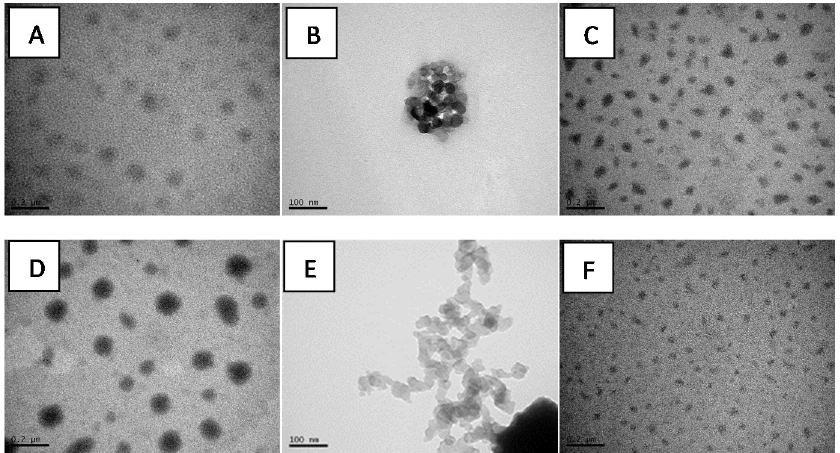
Figure 1. TEM micrographs of 30BSA/70ALG ( A ), 30BSA/70ALG–Fol ( B ), PTX-loaded 30BSA/70ALG–Fol ( C ), 50BSA/50ALG ( D ), 50BSA/50ALG–Fol ( E ) and PTX-loaded 50BSA/50ALG– Fol ( F ) nanoparticles.